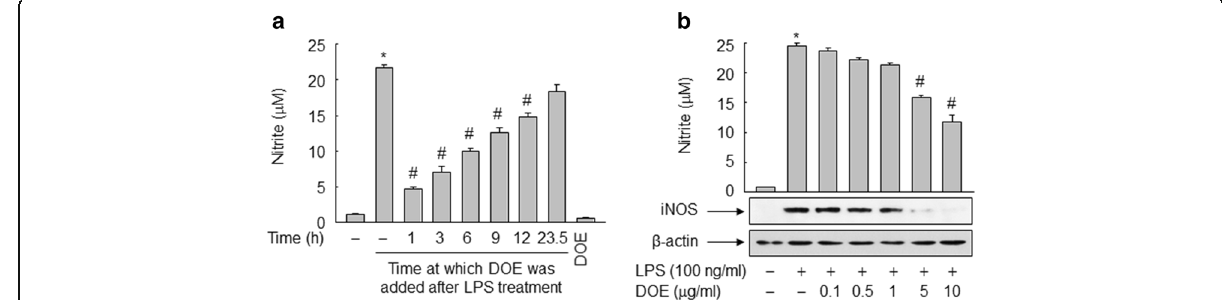
Fig. 4 DOE inhibits LPS-triggered iNOS expression and NO formation in RAW 264.7 cells. a Cells cultured for 24 h in serum-free medium were triggered by vehicle (DMSO) or LPS. DOE was added at the indicated time points after LPS treatment for 24 h. The levels of nitrite were determined by incubation with Griess reagents. b Cells cultured for 24 h in serum-free medium were triggered by vehicle (DMSO) or LPS with or without indicated concentrations of DOE. After incubation for 24 h, aliquots of whole-cell lysates or conditioned media were subjected to immunoblot or nitrite analysis, respectively. The results are plotted as the means ± S.E. ( n = 6). * , p < 0.01 vs untreated group; # , p < 0.01 vs LPS-treated